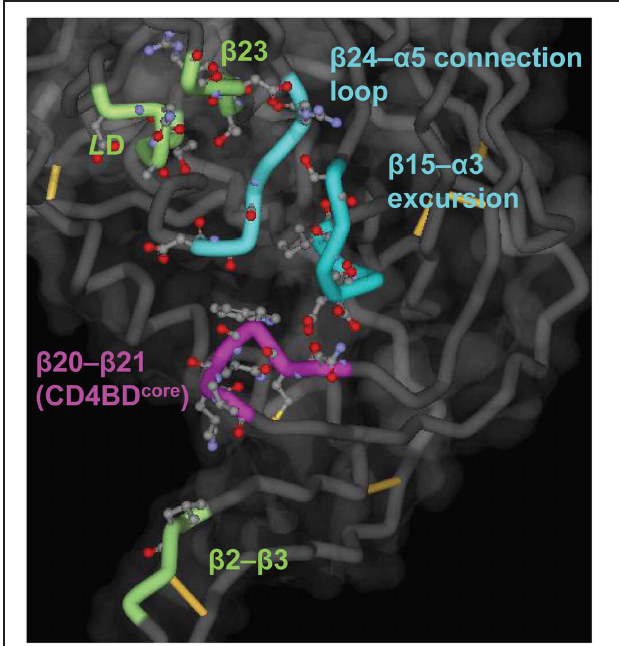
FIGURE 1 | Putative CD4BD structure. The structure was deduced from the complex of gp120 (core), soluble CD4 and antibody 17b (Kwong et al., 1998). The main chain is shown as a tube, with the CD4BD OD elements of the so-called Phe43 pocket in blue (the cavity into which CD4 residue Phe43 penetrates) and the CD4BD core elements located in the bridging sheet in purple. Other CD4 contacting residues are in green. Side chain atoms of CD4 contacting residues are shown as ball-and-stick structures. Created with PDB data